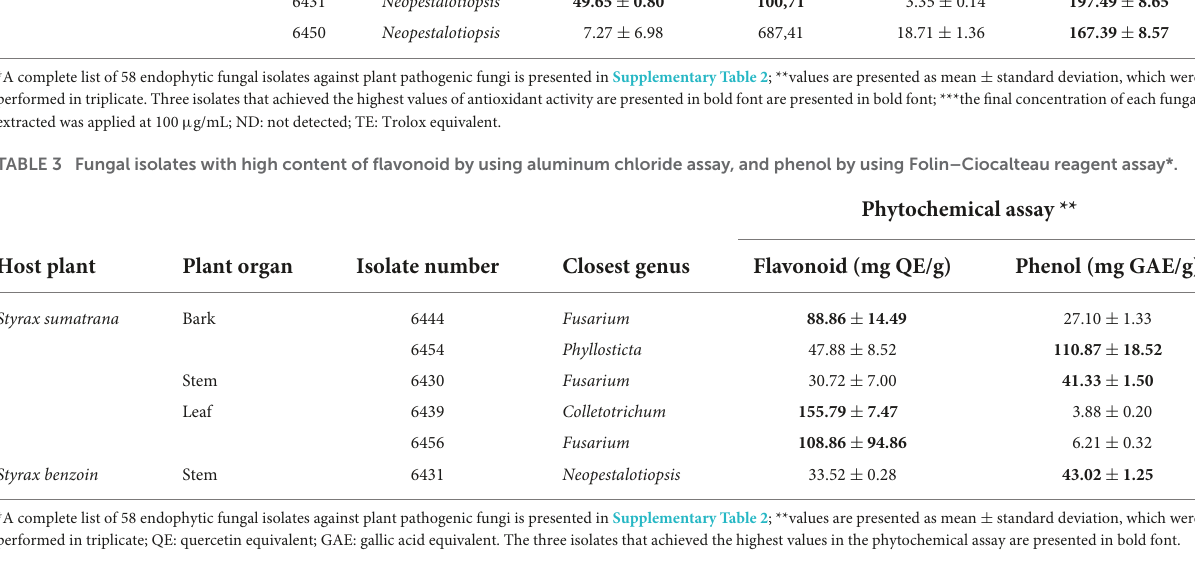
TABLE 4 Fungal isolates with high α -glucosidase inhibition determined by p-nitrophenyl- α -D-glucopyranoside as